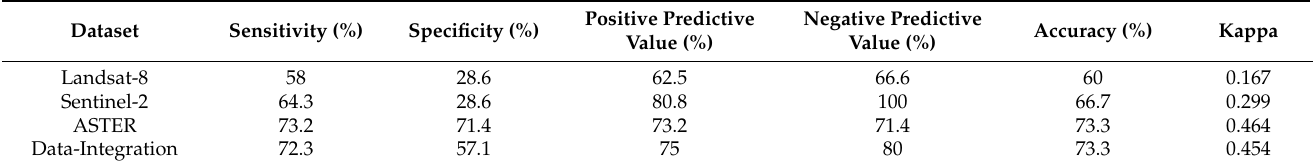
Figure 12. Predictive maps of likelihood score of gold propsectivity obtained from RF predictive modeling using: ( a ) Landsat-8; ( b ) Sentinel-2; ( c ) ASTER; and ( d ) Data-integration. Table 8. classification report of RF performance using different datasets.